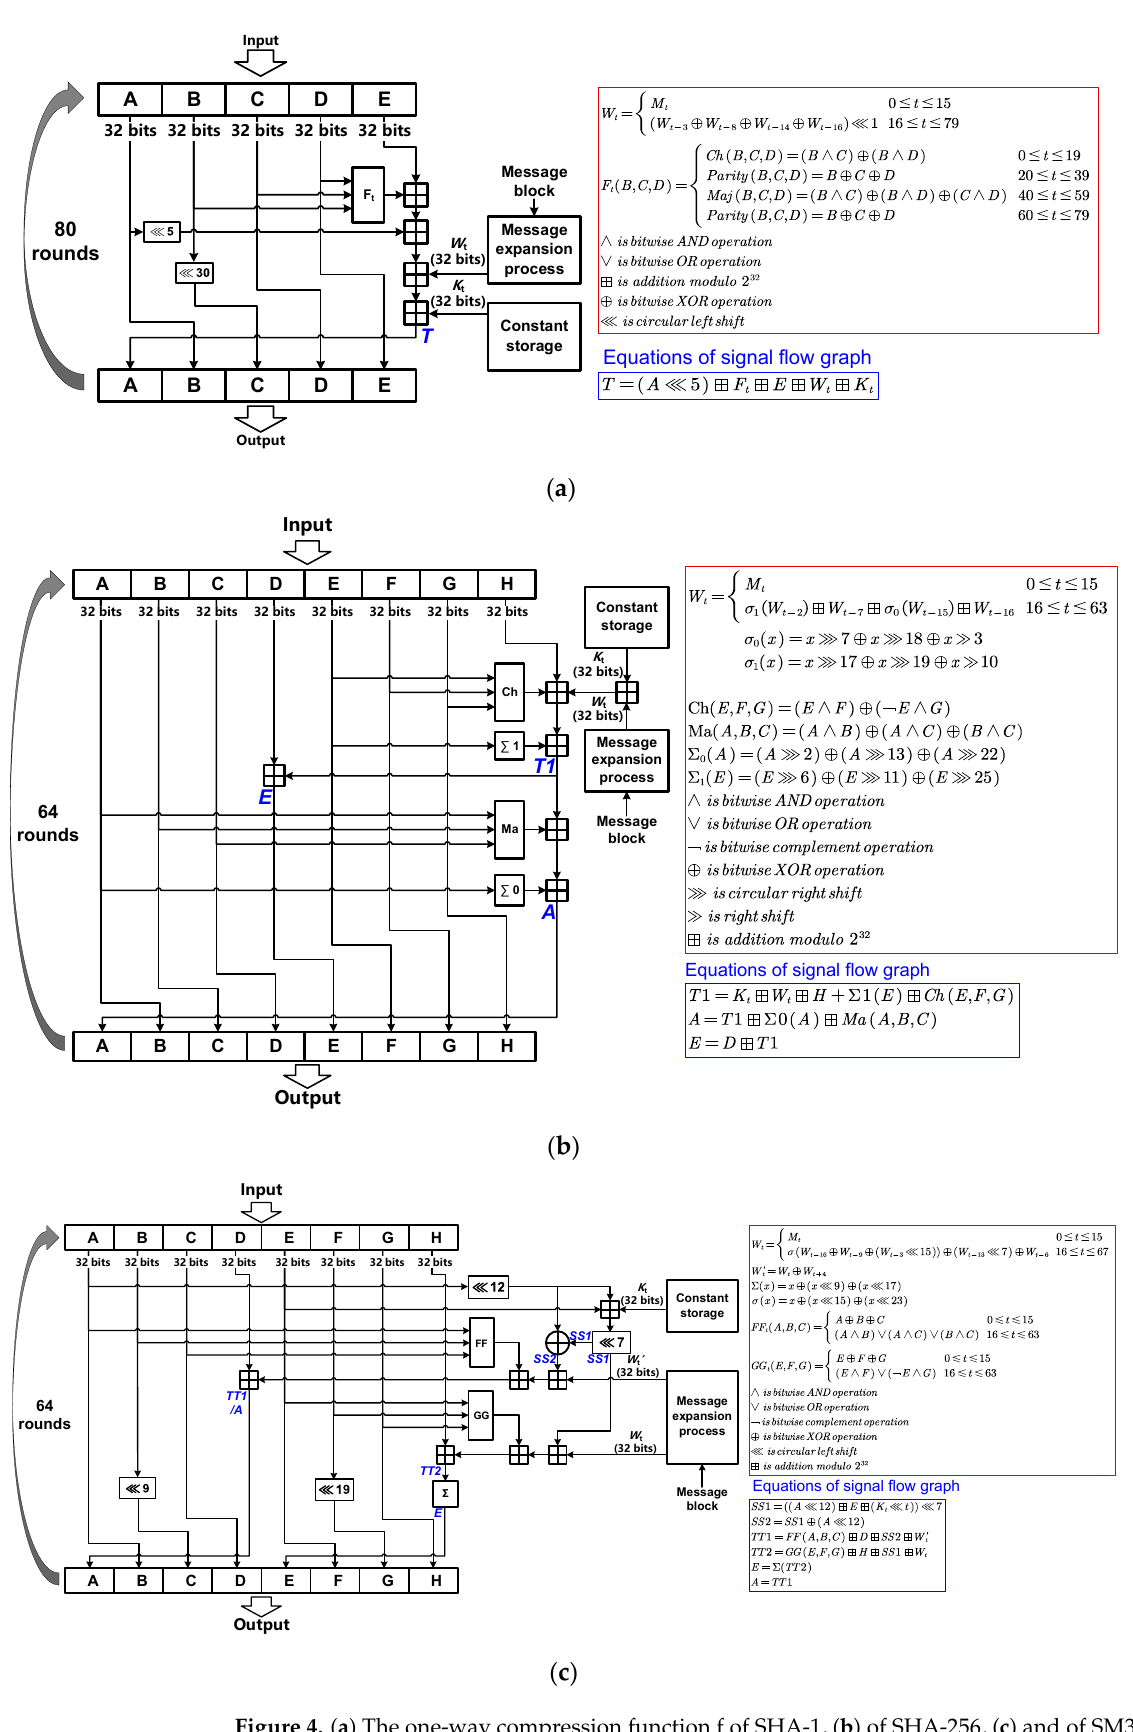
Figure 4. ( a ) The one-way compression function f of SHA-1, ( b ) of SHA-256, ( c ) and of SM3.